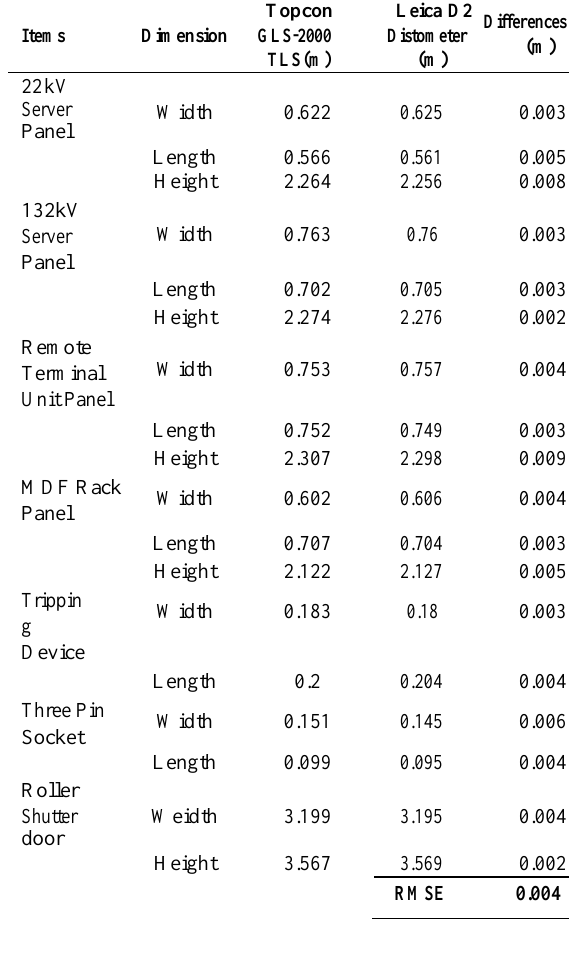
Table 1: Comparison of distances between terrestrial laser scanning and